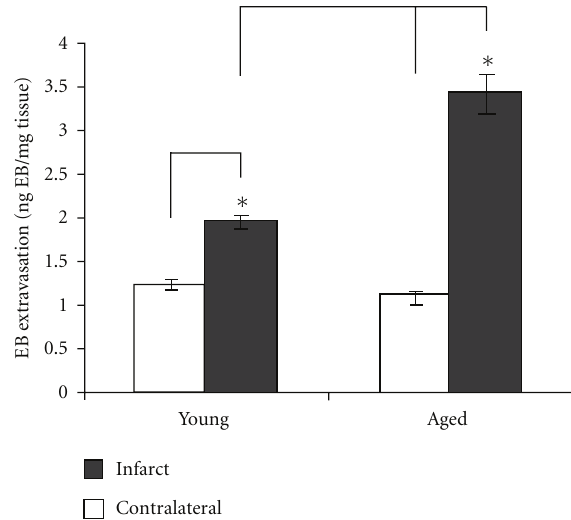
Figure 2: Extravasation of albumin across the BBB 20min after- MCAO. The aged animals exhibited greater BBB permeability in relation to the corresponding young rats in the infarcted hemi- sphere ( P < 0 . 001). (Copyright: DiNapoli et al. [107]).